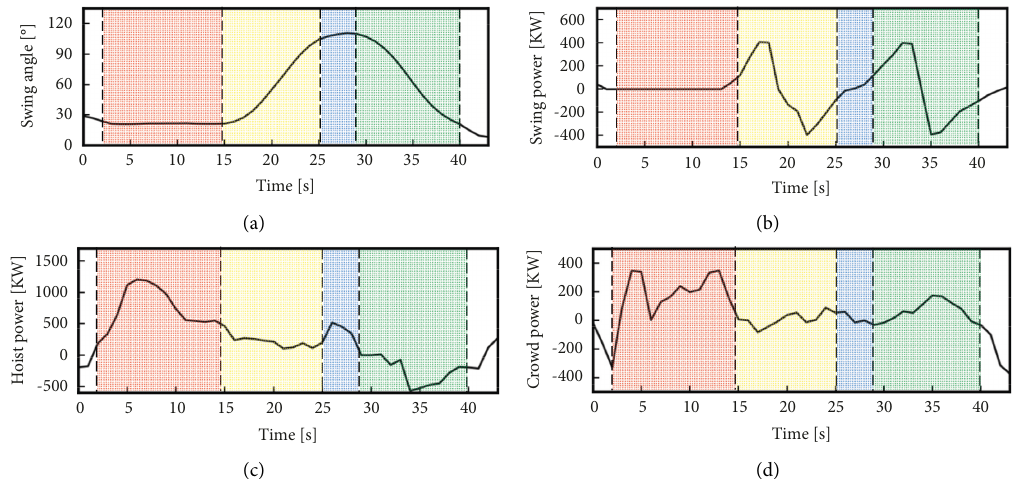
Figure 3: Monitoring parameter curves and partitions in a loading cycle. (a) Waveform change of the swing angle; (b) waveform change of the swing power; (c) waveform change of the hoist power; (d) waveform change of the crowd power. The red, yellow, the blue, and green zones represent the digging, load swing, dump, and empty bucket return stages,